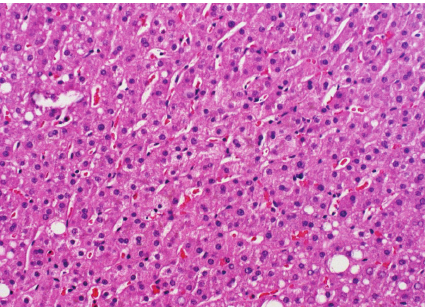
Figure 3: Liver biopsy reveals centrilobular steatosis without fibro- sis. (Hematoxylin and eosin,